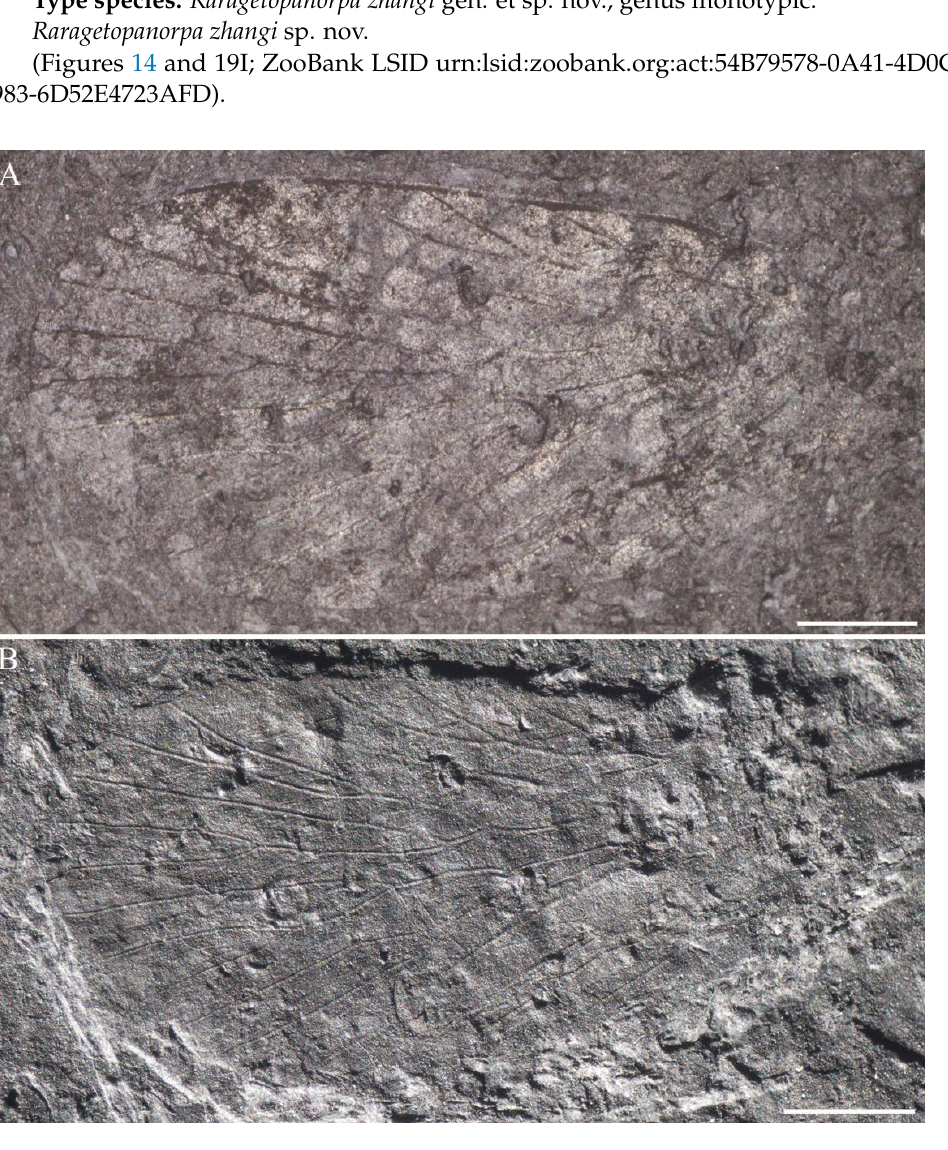
Figure 14. Raragetopanorpa zhangi sp. nov., NIGP200927 (holotype). ( A ) Photograph was taken when specimen was immersed under 70% alcohol in vertical reflected light; ( B ) Photograph was taken in oblique reflected light. Scale bars represent 1 mm in ( A , B ).